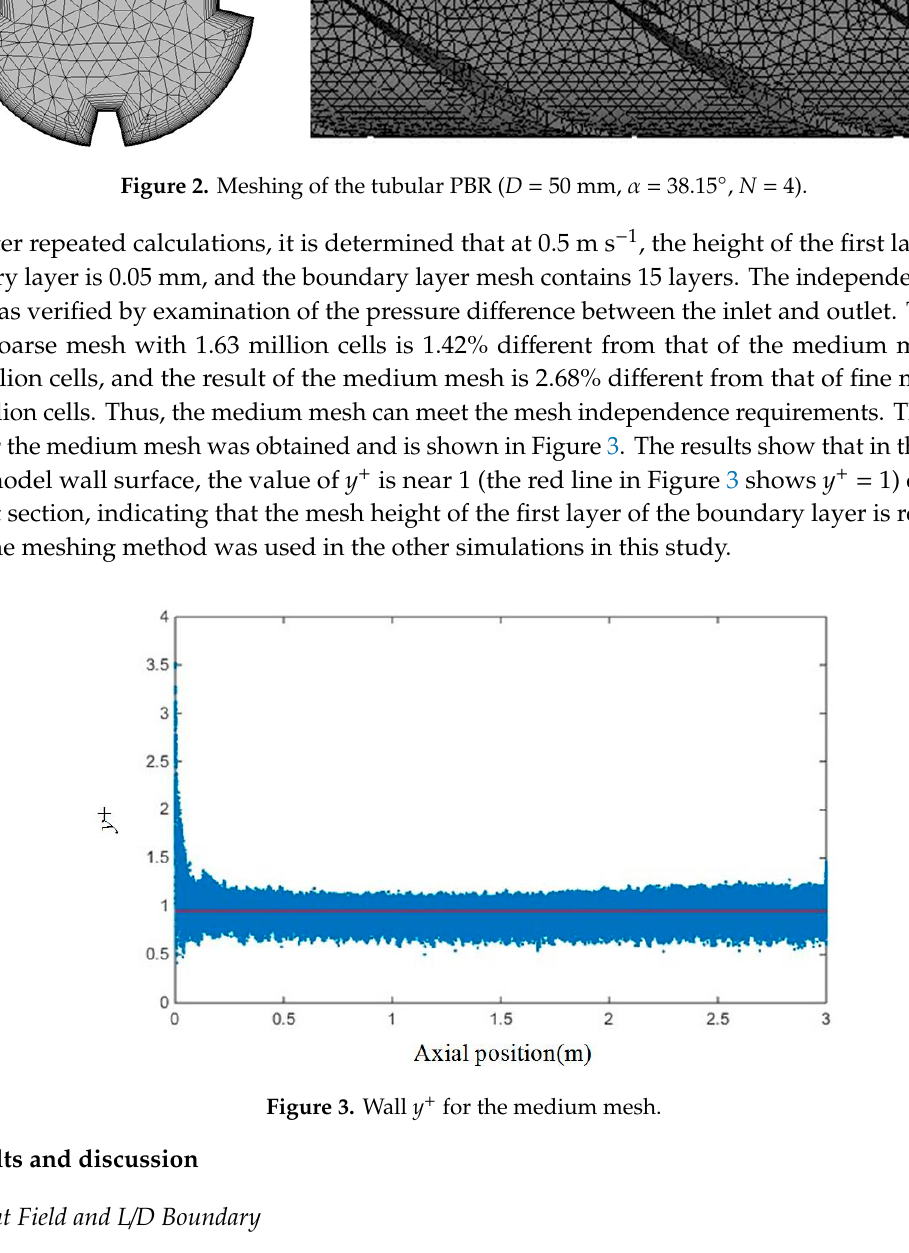
Figure 3. Wall y + for the medium mesh.